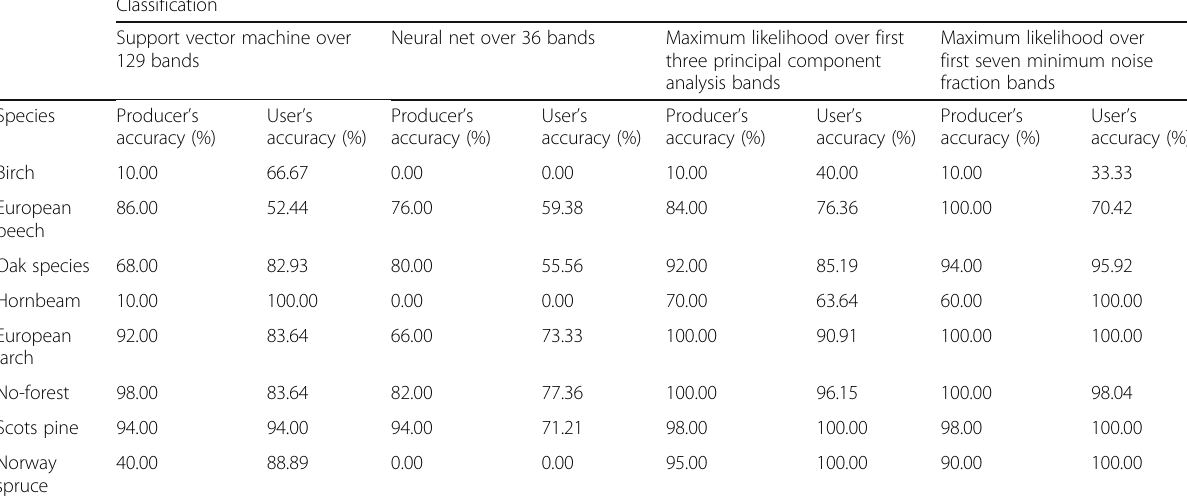
Table 3 The producer ’ s and user ’ s accuracy for each class using different datasets and algorithms